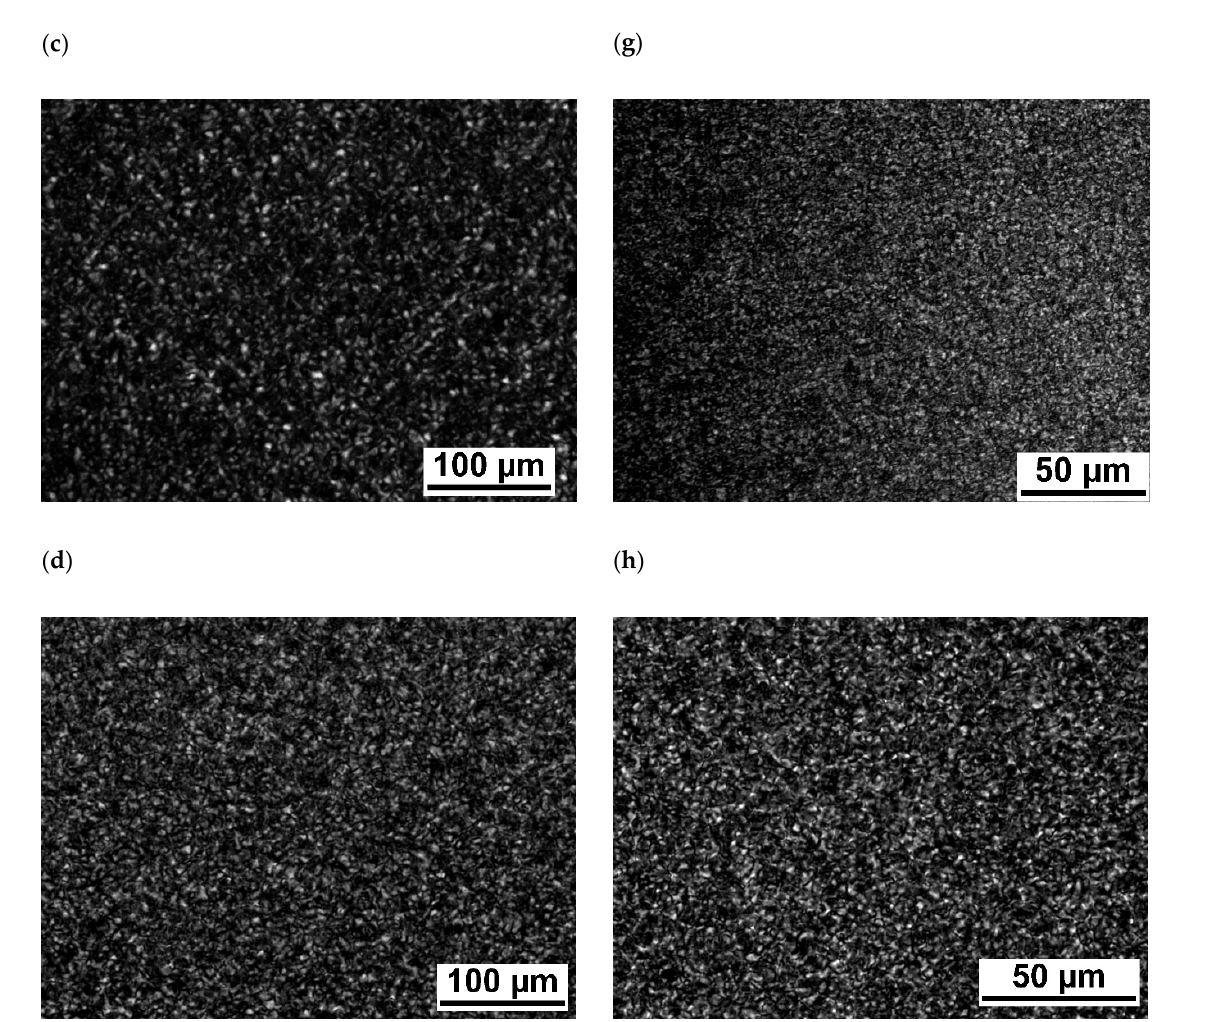
Figure 3. PLM micrographs of PBASGT specimens: not sheared ( a ) and sheared for 45 s at 100 s − 1 ( b ), 200 s − 1 ( c ), and 300 s − 1 ( d ); PBAT specimens: not sheared ( e ) and sheared for 45 s at 100 s − 1 ( f ), 200 s − 1 ( g ), and 300 s − 1 ( h ).